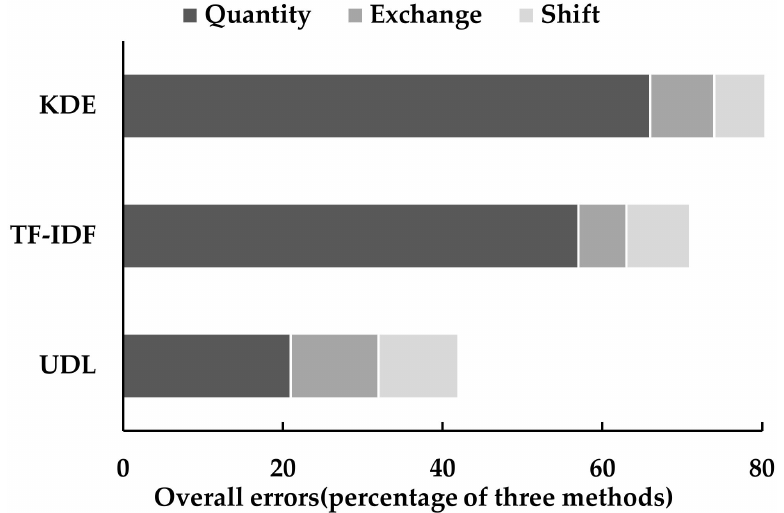
Figure 6. Overall errors of three